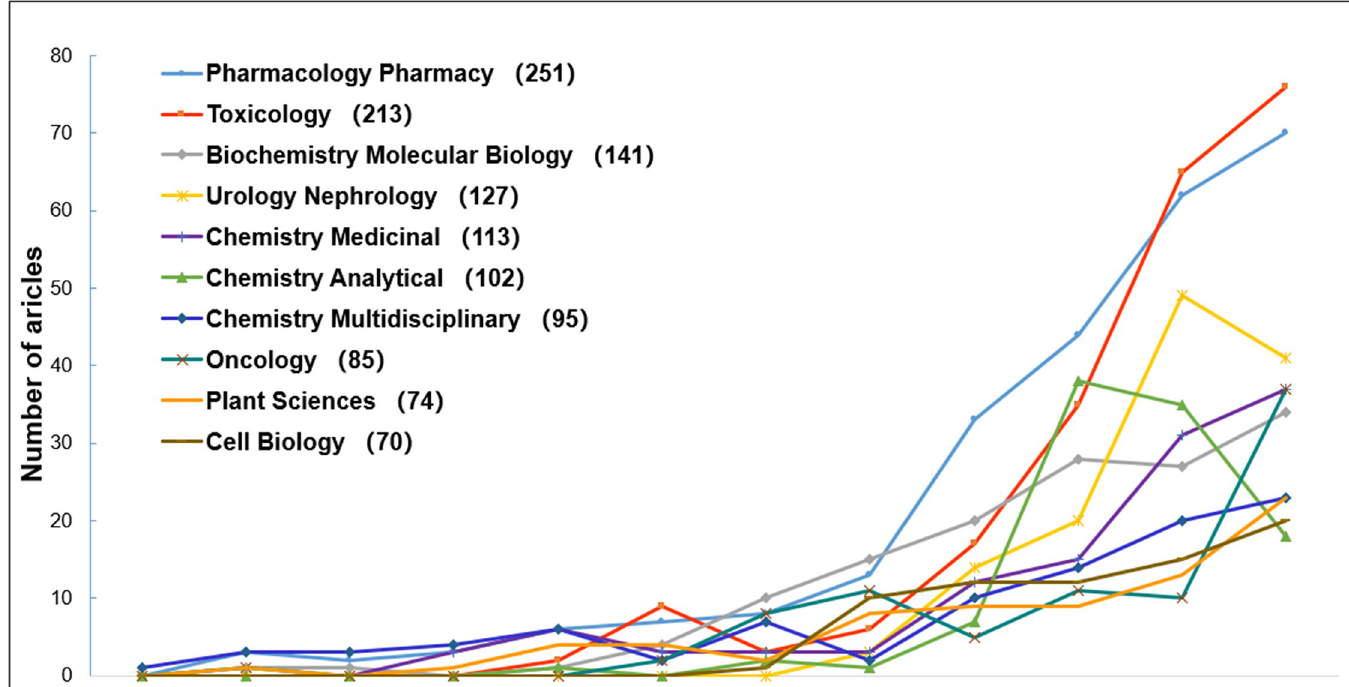
Fig 6. Timeline of articles in the Top 10 most productive